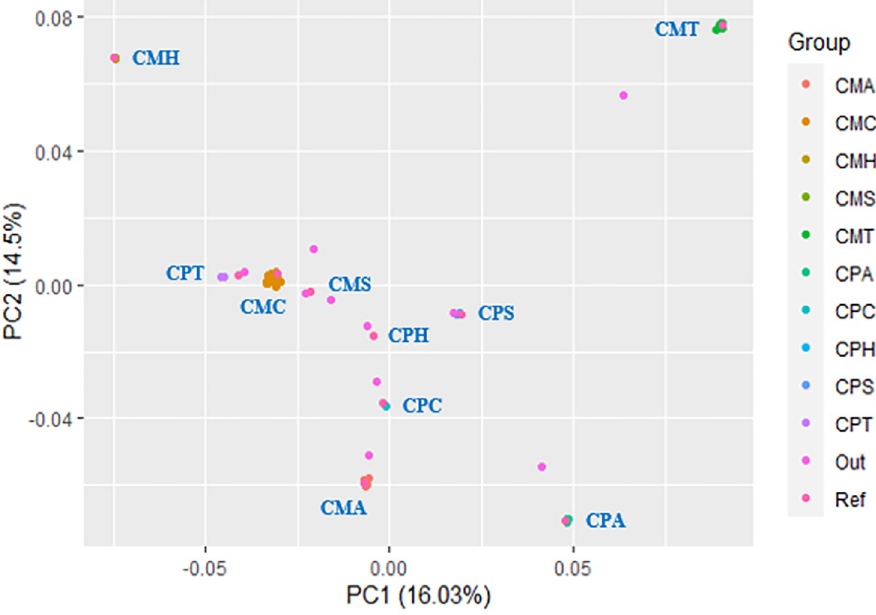
Fig 2. Principal component analysis (PCA) between different genes of total cDNA sequences. Mr: M . rosenbergii ; Pm: P . monodon . CMA: Mr ALF3 cDNA, CMC: Mr C-type Lectin cDNA, CMH: Mr HMGB cDNA, CMS: Mr STAT cDNA, CMT: Mr ATPase 8/6 cDNA; CPA: Pm ALF3 cDNA, CPC: Pm C-type Lectin cDNA, CPH: Pm HMGB cDNA, CPS: Pm STAT cDNA, CPT: Pm ATPase 8/6 cDNA. Out: Outgroup; Ref: